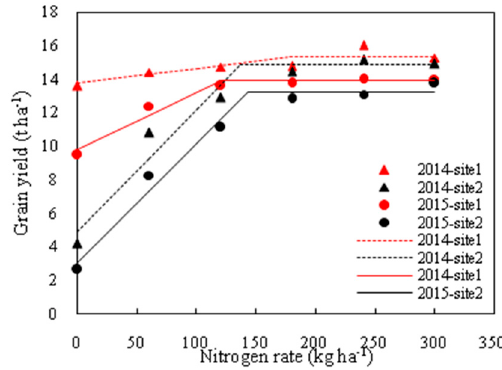
Figure 2. Maize grain yield responses to N fertilizer application rates in different site-years.